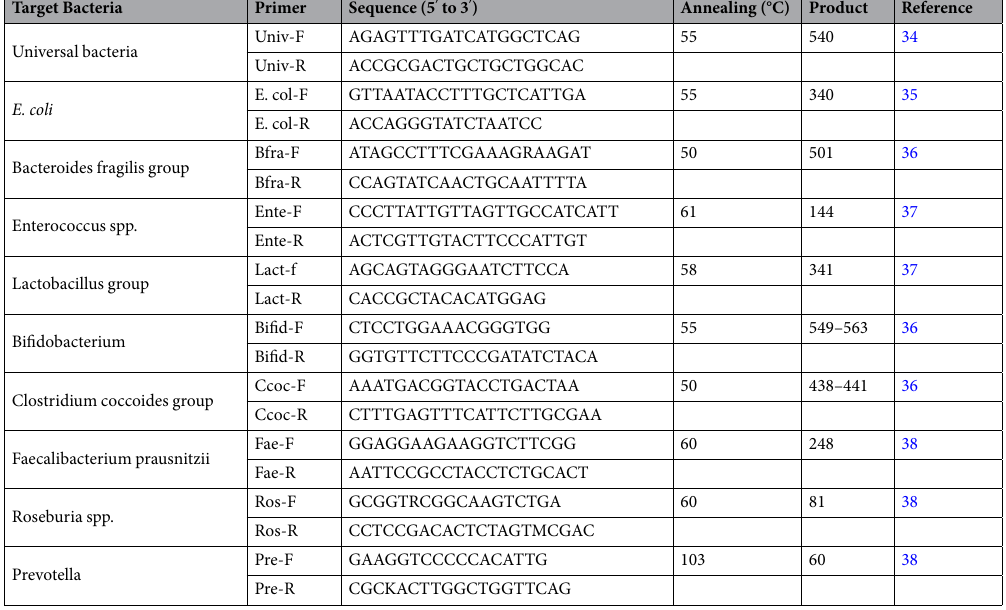
Table 2. Primers used for qPCR in this Assessment of clinical parameters.